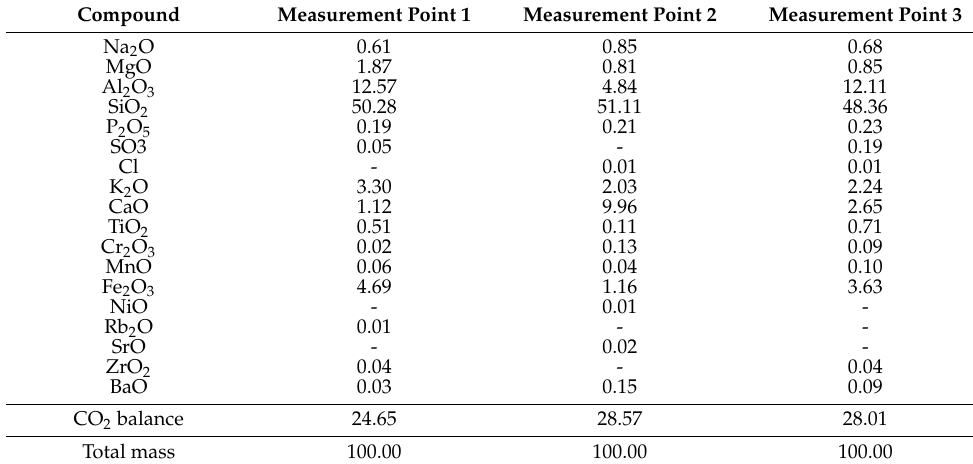
Table 2. Chemical composition of samples.